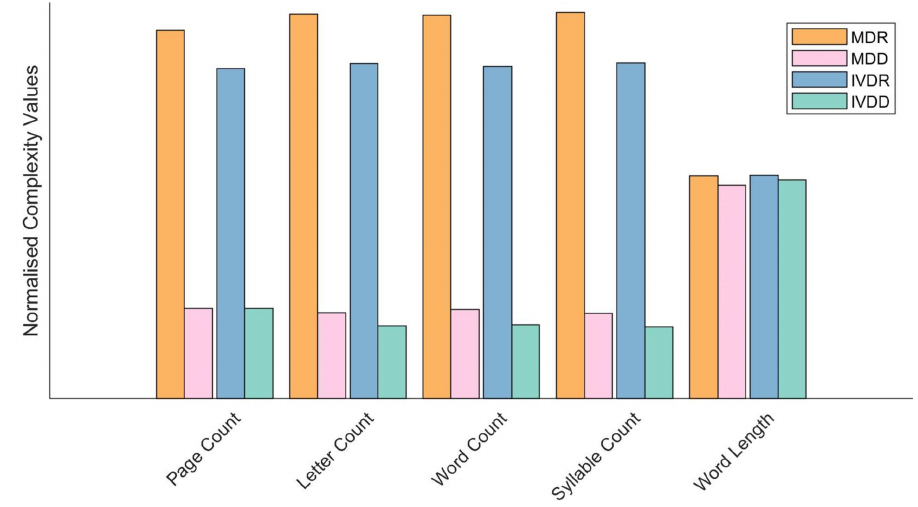
Figure 1. Descriptive complexity scores for the MDR, MDD, IVDR and IVDD. The word length represents the average word length.